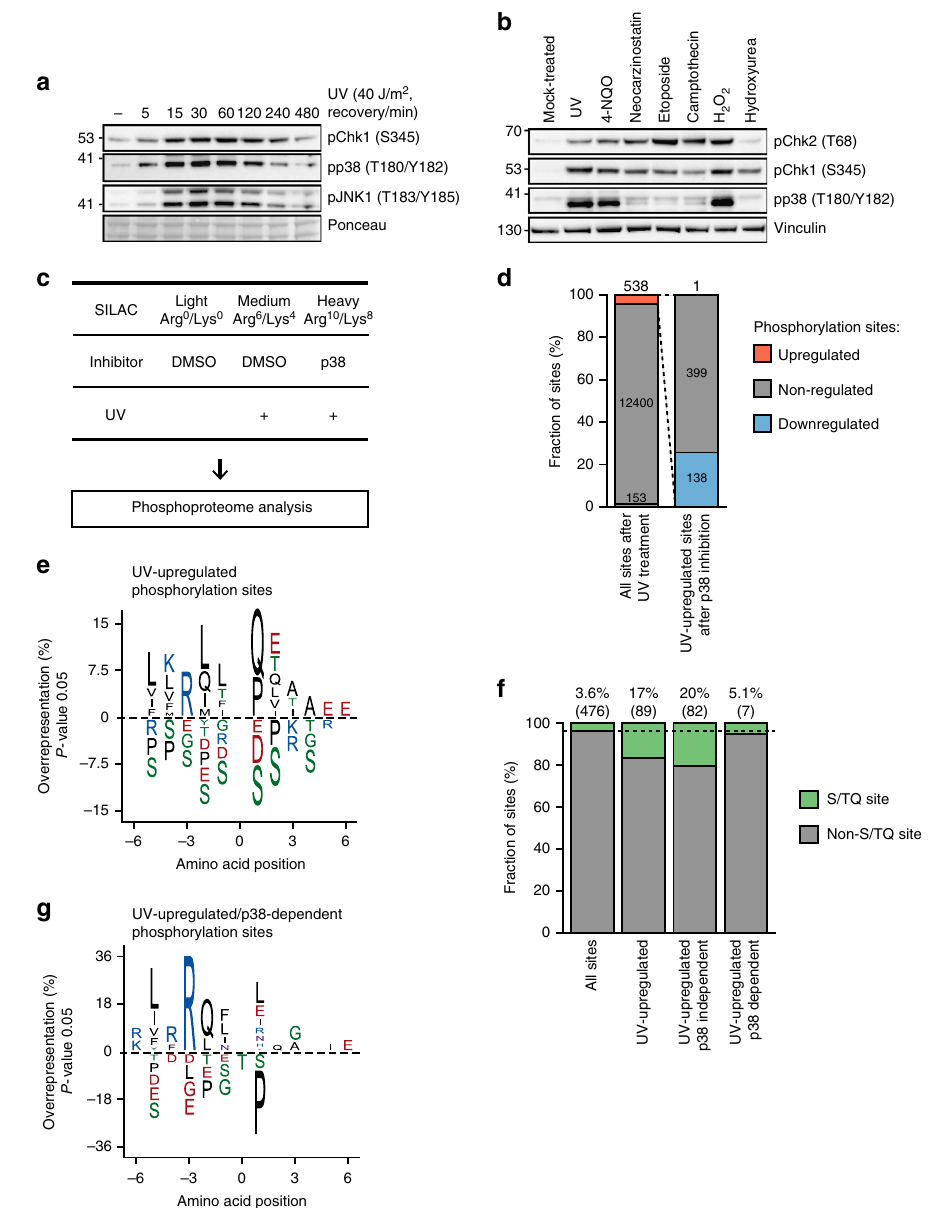
Fig. 1 Phosphoproteomics reveals a broad scope of p38 signaling after UV light. a U2OS cells were treated with UV light (40 J/m 2 ) and left to recover for the indicated times. Total cell lysates were resolved on SDS-PAGE and activation of p38, JNK1, and Chk1 was monitored with phospho-speci fi c antibodies. b U2OS cells were left untreated or treated with UV light (40 J/m 2 , 1 h recovery), 4-nitroquinoline 1-oxide (4-NQO, 20 µ M, 1 h), neocarzinostatin (400 µ g/ ml, 1 h), etoposide (10 µ M, 1 h), camptothecin (10 µ M, 1 h), H 2 O 2 (2 mM, 1 h), and hydroxyurea (2 mM, 1 h). Total cell lysates were resolved on SDS-PAGE and blotted with the indicated antibodies. c Schematic representation of the strategy used to identify UV-light-induced, p38-dependent phosphorylation sites. SILAC-labeled U2OS cells were mock-treated (Light), irradiated with UV light (40 J/m 2 , 1 h recovery) (Medium), or pretreated with the p38 inhibitor (SB203580, 10 µ M, 1 h) or transfected with p38 siRNA, and irradiated with UV light (40 J/m 2 , 1 h recovery) (Heavy). Phosphorylated peptides were enriched using TiO 2 and peptide samples were analyzed by LC-MS/MS. d The bar graph shows the number of signi fi cantly up-, non-, and downregulated UV-light-induced phosphorylation sites after p38 inhibition identi fi ed from two replicate experiments ( p- value < 0.01, moderated t -test). Signi fi cantly regulated phosphorylation sites were calculated as shown in Supplementary Figure 1f, g. e Sequence motif analysis of 538 UV-light-induced phosphorylation sites. The iceLogo plot shows frequency of six amino acids fl anking phosphorylated residue. The frequencies of amino acids surrounding phosphorylated residues in UV-light-induced phosphorylation sites was compared with frequencies in all quanti fi ed phosphorylation sites. A signi fi cant overrepresentation of phosphorylation sites conforming to the ATM/ATR/DNA-PKcs motif (S/TQ) is observed among UV-light-induced sites. f The bar graph shows the absolute number and percentage of S/TQ sites among all quanti fi ed phosphorylation sites, UV-light-upregulated sites, UV-light- upregulated, p38-independent sites, and UV-light-upregulated, p38-dependent sites. g Sequence motif analysis of 138 UV-light-induced, p38-dependent phosphorylation sites. The analysis was done as described in Fig.